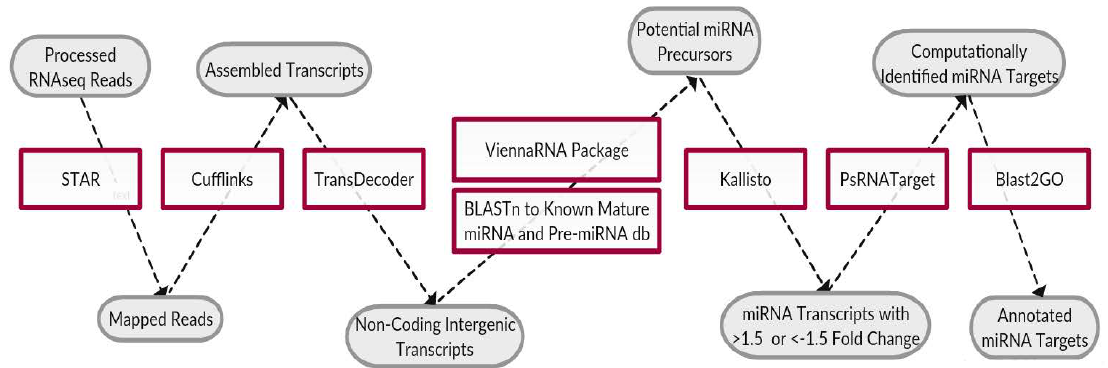
Figure 1: Demonstration of the computational strategy, red boxes indicate the software tool used in this